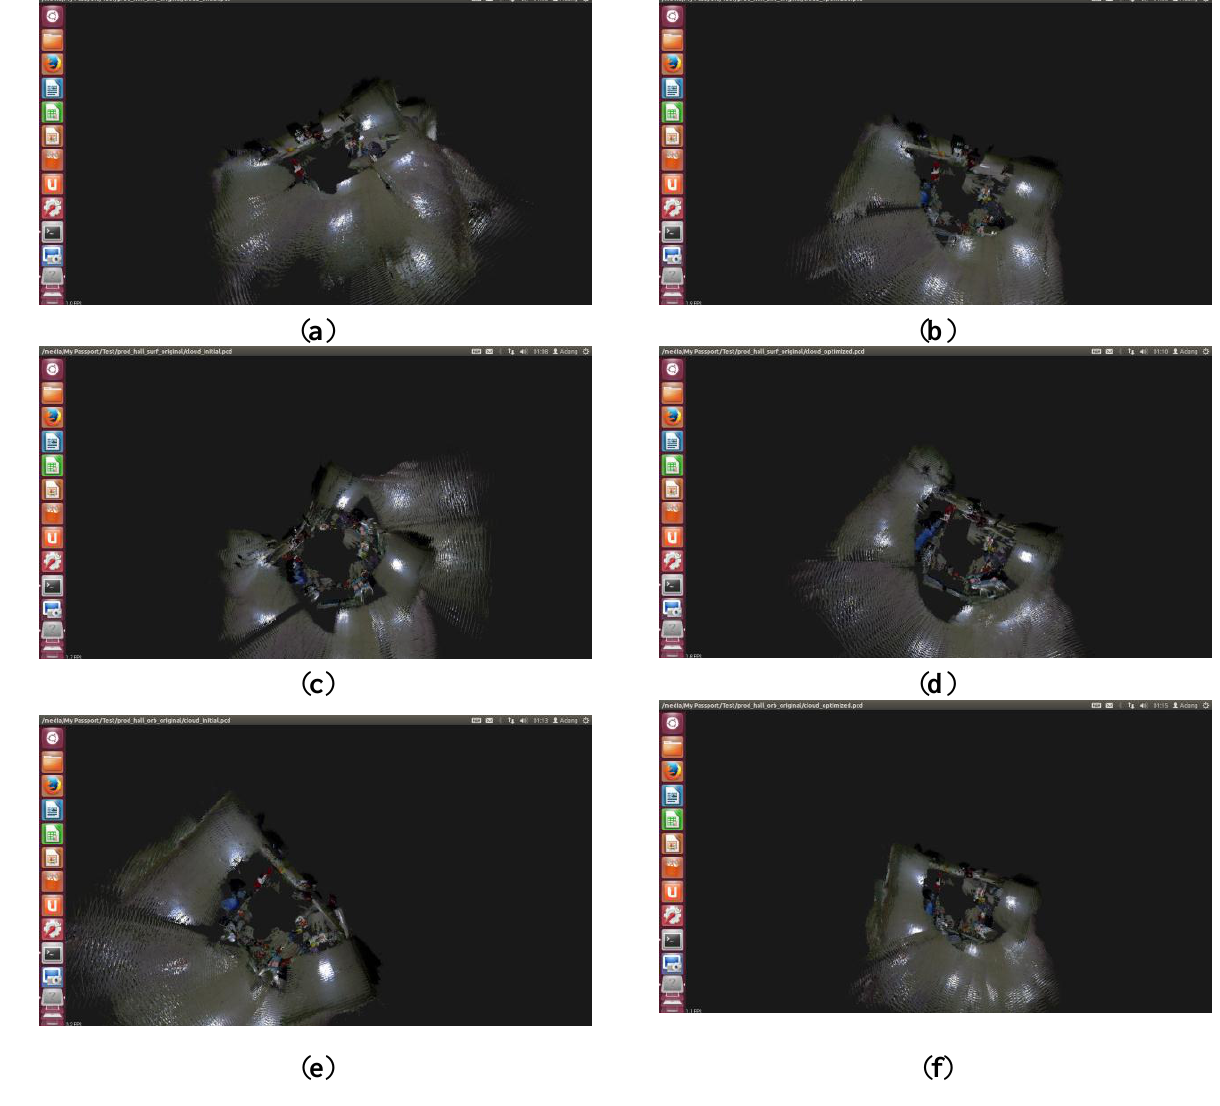
Figure 14. The splicing results for the original RGB-D SLAM based on Dr Robot X80.